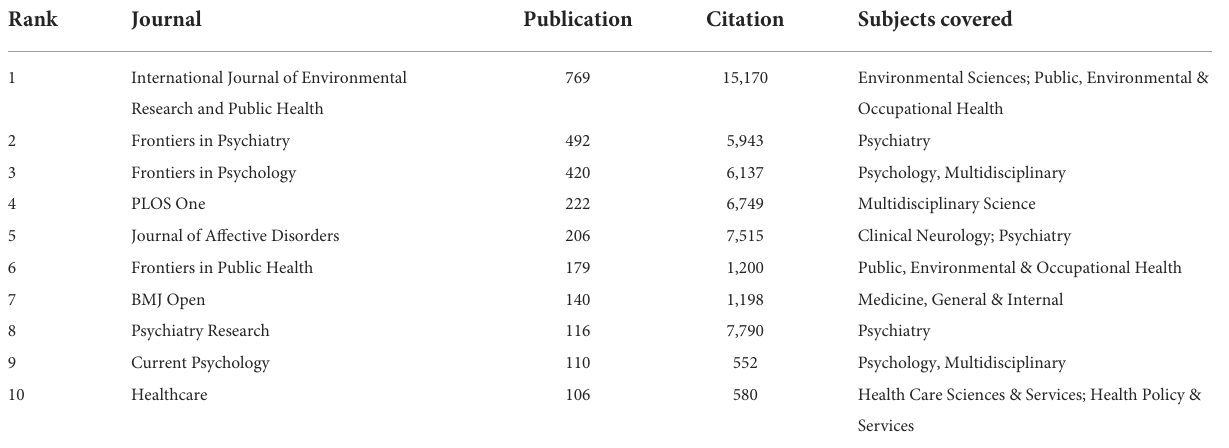
TABLE 2 Top 10 journals ranked by number of